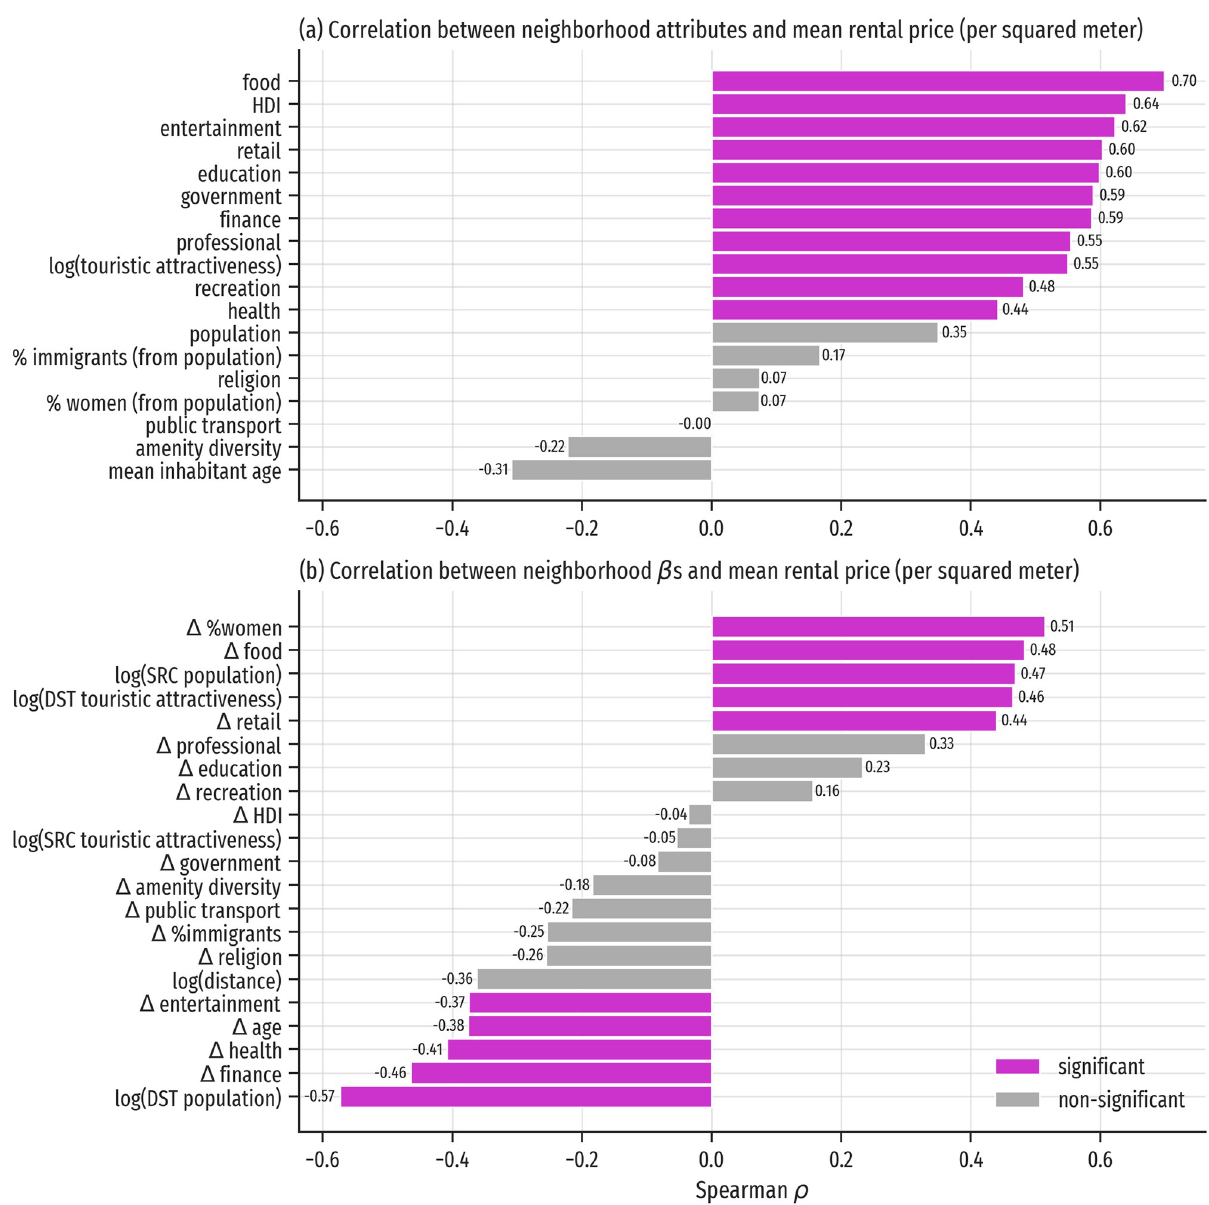
Fig 7. Correlations between neighborhoods’ attributes and mobility factors with relative rental prices. Grey bars represent non-statistically significant correlations, magenta bars represent statistically significant correlations; significance was determined with Bonferroni-corrected p -values (significance level 0.05). a) Spearman correlation between neighborhood features and rental price per square meter. b) Spearman correlation between neighborhood local mobility factors and rental price per square